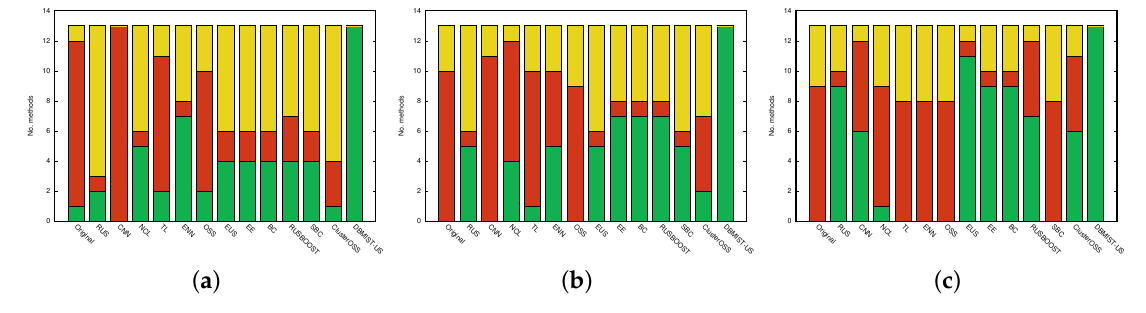
Figure 9. Summary of the Wilcoxon’s test. ( a ) 1NN; ( b ) J48; ( c )